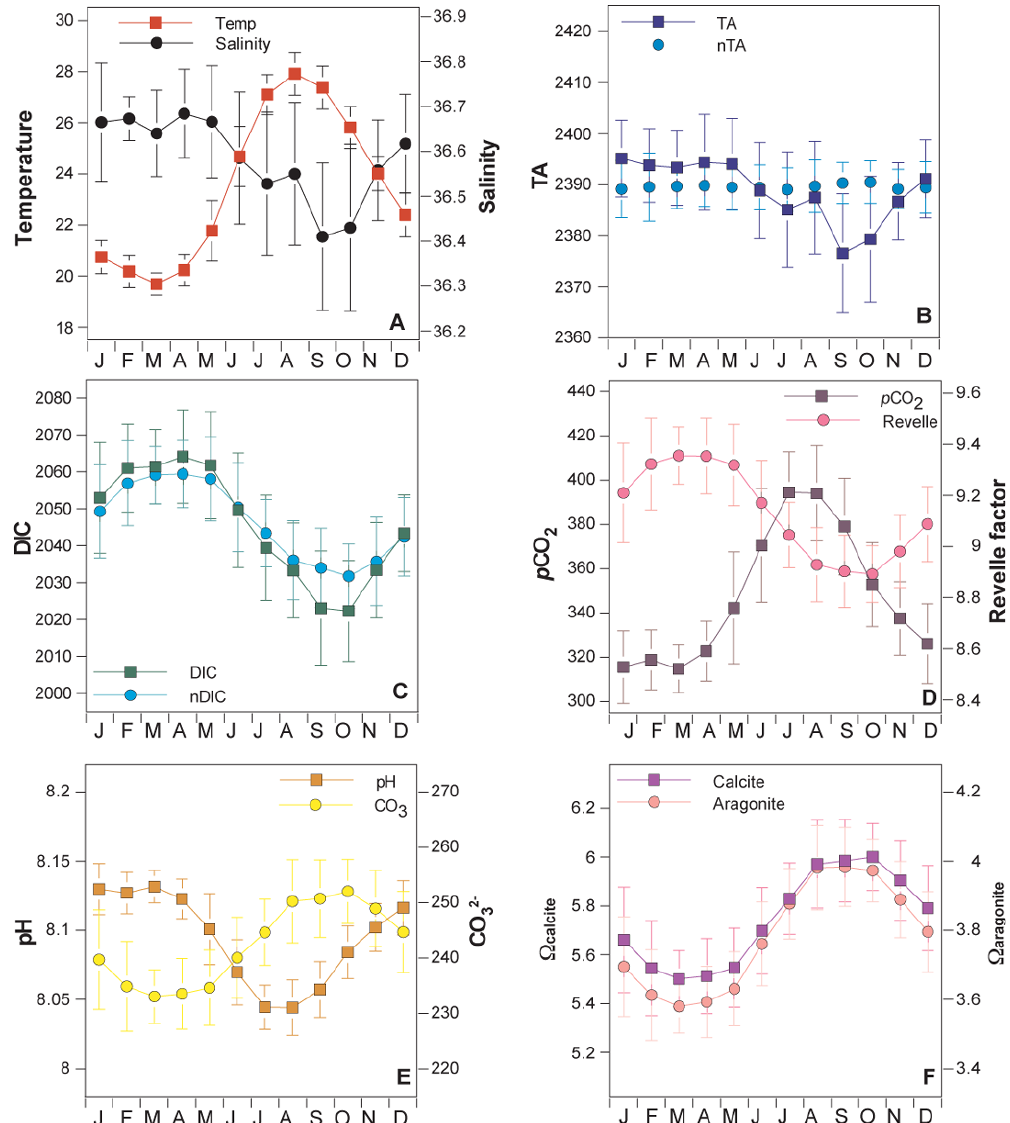
Fig. 4. Mean monthly values for surface temperature and salinity ( A ), total alkalinity ( B , µmolkg − 1 ) ; DIC ( C , µmolkg − 1 ) , seawater p CO 2 and Revelle factor β ( D , µatm), pH and [CO 2 − ] ( E , µmolkg − 1 for [CO 2 − ]), and (cid:127) calcite and (cid:127) aragonite ( F ), at BATS/Hydrostation S for the 3 3 period 1983–2011. The standard deviation is shown by y error